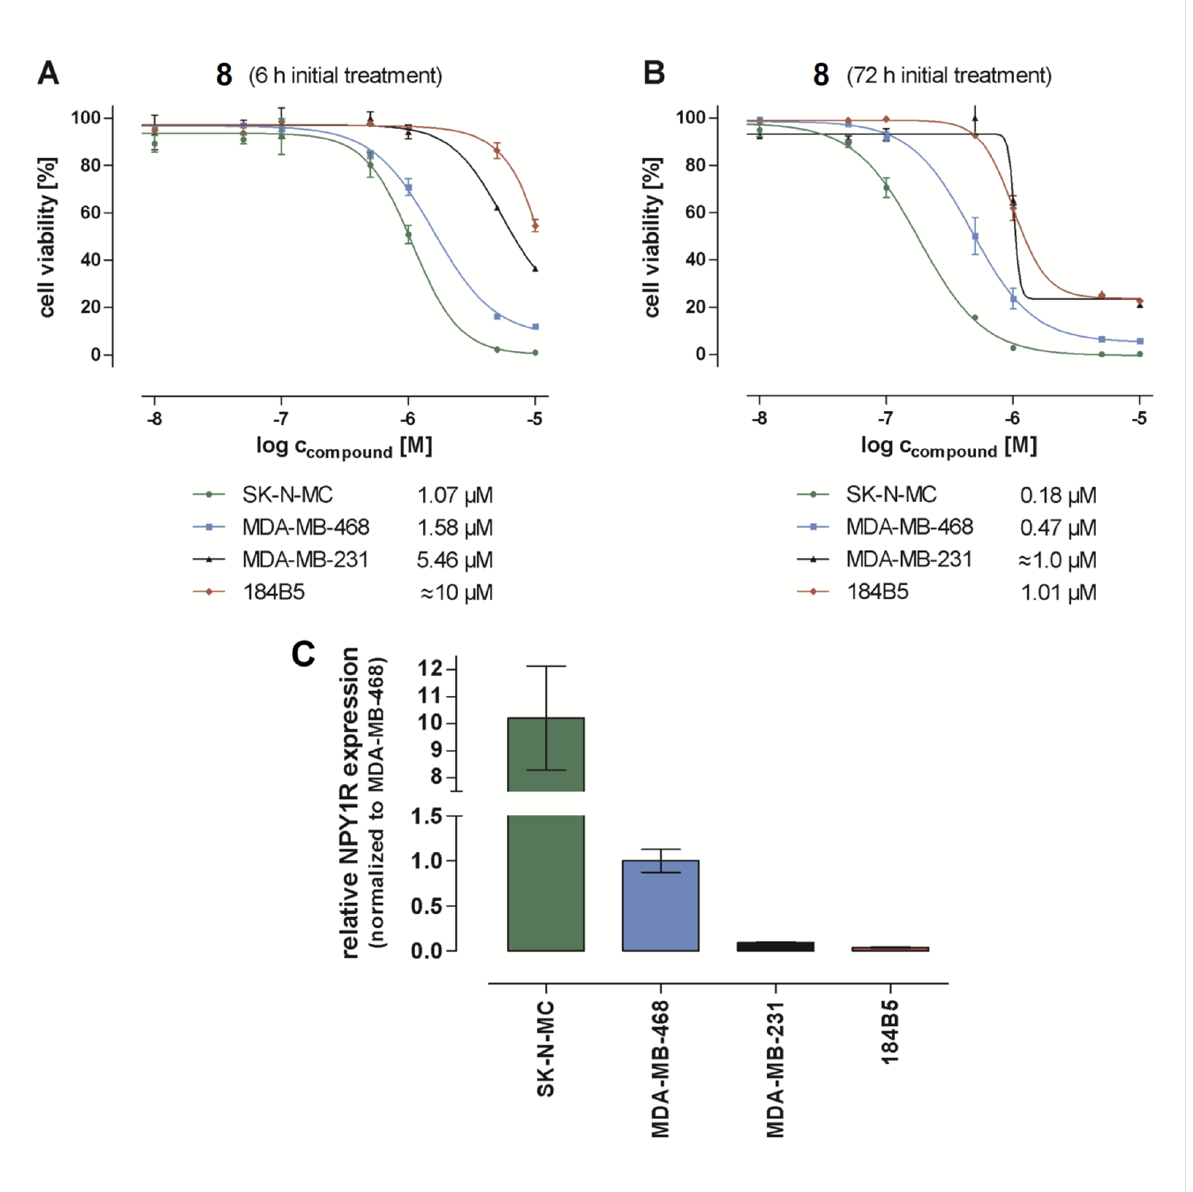
Figure 2: Reduction of viability and proliferation of SK-N-MC, MDA-MB-468, MDA-MB-231 cancer cell lines, and normal mammary gland epithelium cell line 184B5 treated with NPY Y1 receptor-targeting peptide–toxin conjugate 8 : (A) pulse setting (initial 6 h treatment followed by 66 h growth in PDC-free standard medium); (B) 72 h treatment; (C) NPY Y1 receptor expression of the SK-N-MC, MDA-MB-468, MDA-MB-231 and 184B5 cell lines determined by using RT-qPCR quantification; the NPY1R expression levels are normalized to NPY1R expression level in MDA-MB-468 cells (set to